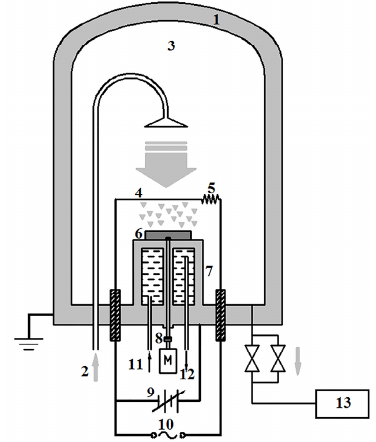
Figure 1. The scheme of the bias ‐ enhanced HFCVD apparatus. 1—Stainless steel bell; 2—Reaction gas